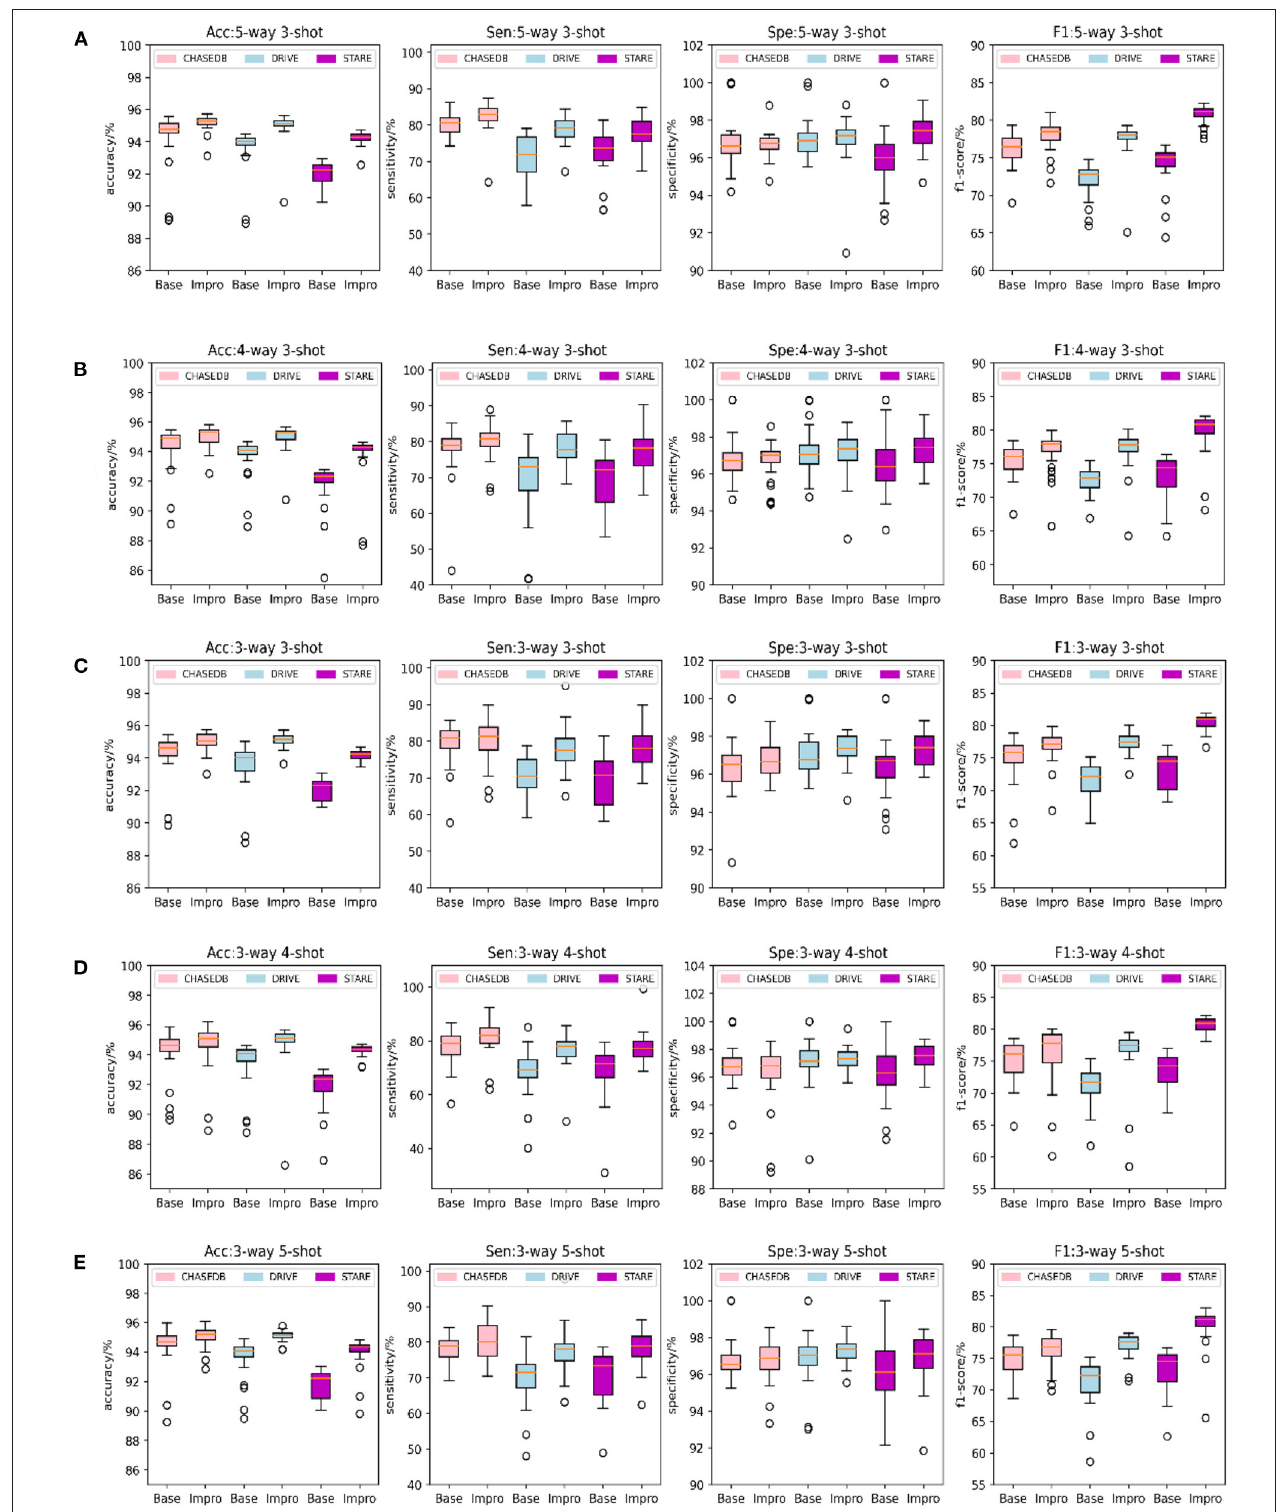
FIGURE 6 | Comparison of the baseline and upgraded models on validation set: (A) 5-way 3-shot; (B) 4-way 3-shot; (C) 3-way 3-shot; (D) 3-way 4-shot; and (E) 3-way 5-shot.